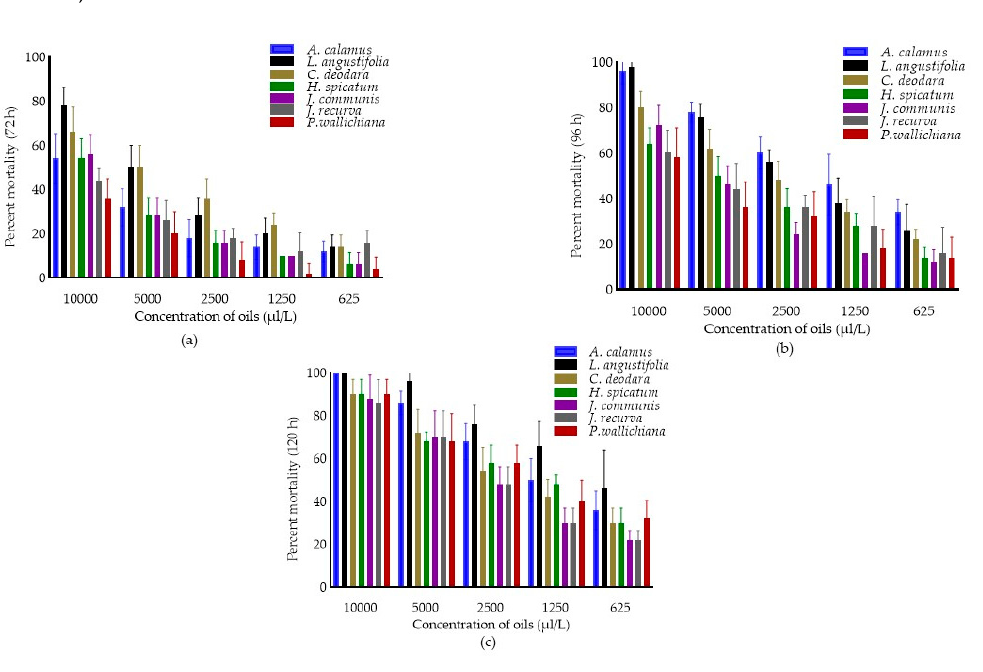
Figure 2. Percent mortality in C. chinensis after 72 h ( a ) 96 h ( b ) and 120 h ( c ). Bars represent the standard deviation ( ± SD) of five replications. Means ± SD in the error bars differs significantly by Tukey’s HSD ( p < 0.0001). The interaction effect (oils × concentrations) showed significantly different against C. chinensis after 72 (F 24,174 = 1.96; p < 0.0001) and 96 h (F 24,174 = 1.89; p < 0.05). Results showed that among oils, pooled mean mortality was higher in L. angustifolia (38.00 ± 25.00) after